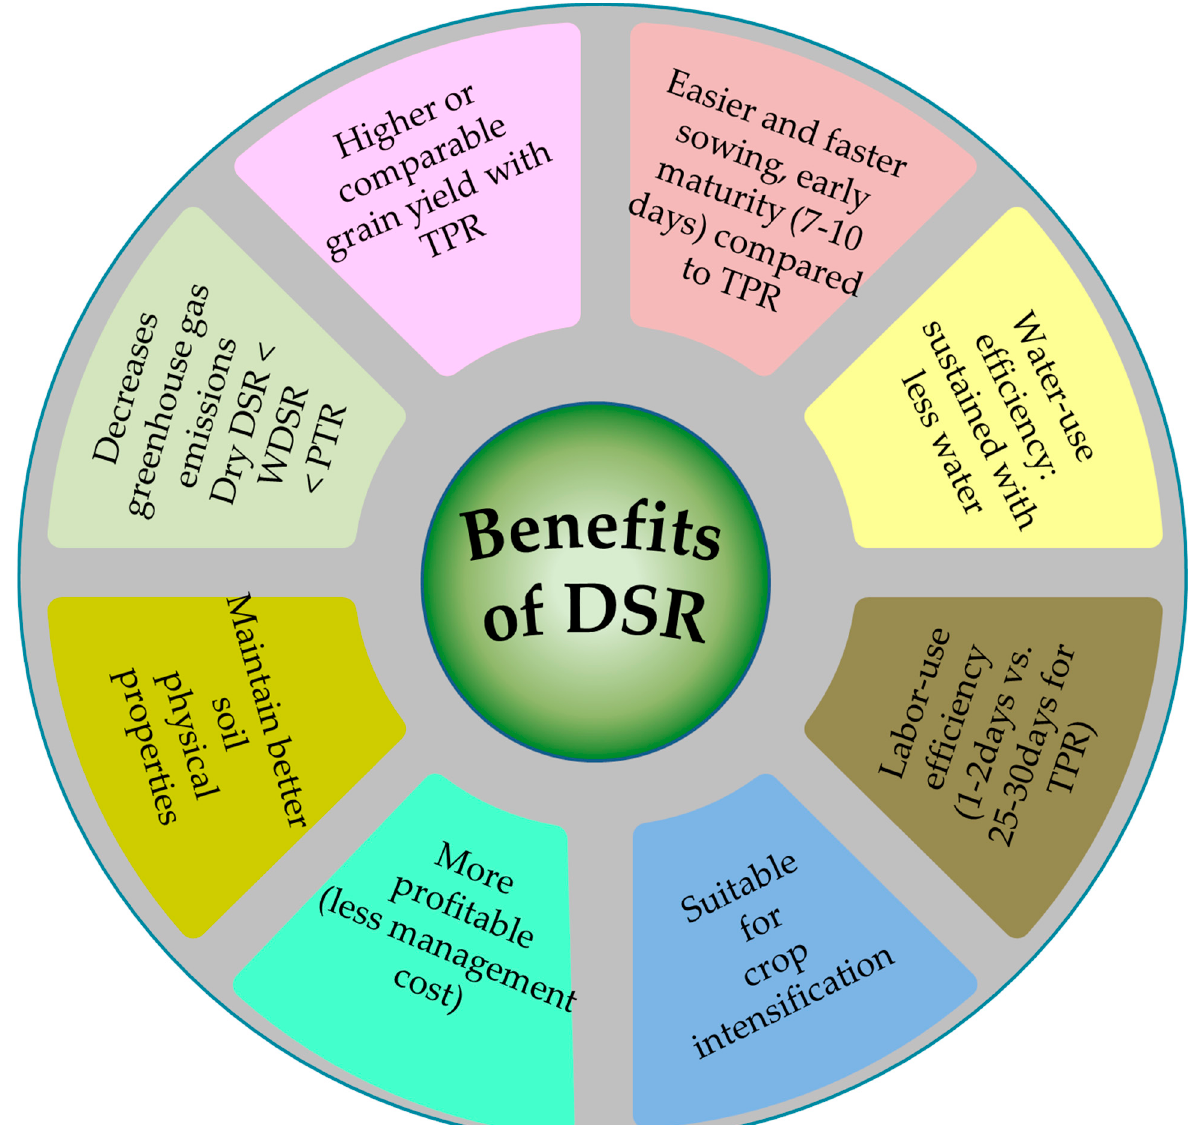
Figure 1. Major benefits of direct-seeded rice (DSR) system over transplanted rice (TPR) system.